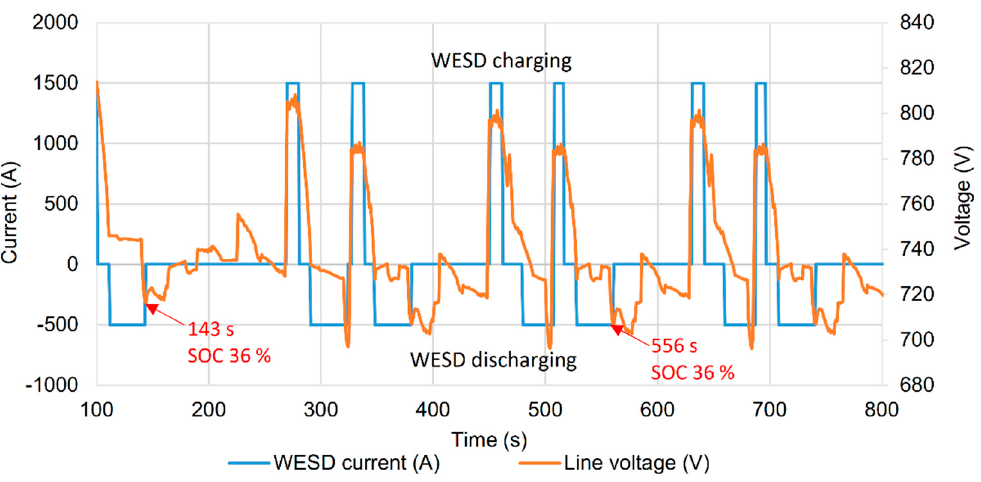
Figure 8. Simulation results (WESD current, line voltage).